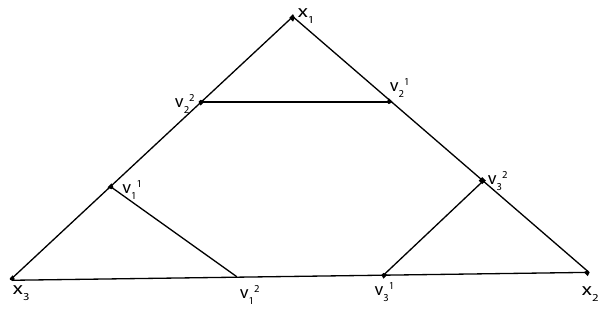
Figure 1. A C 3 -based Sierpinski network with n = 2, S ( 2, C 3 ) .